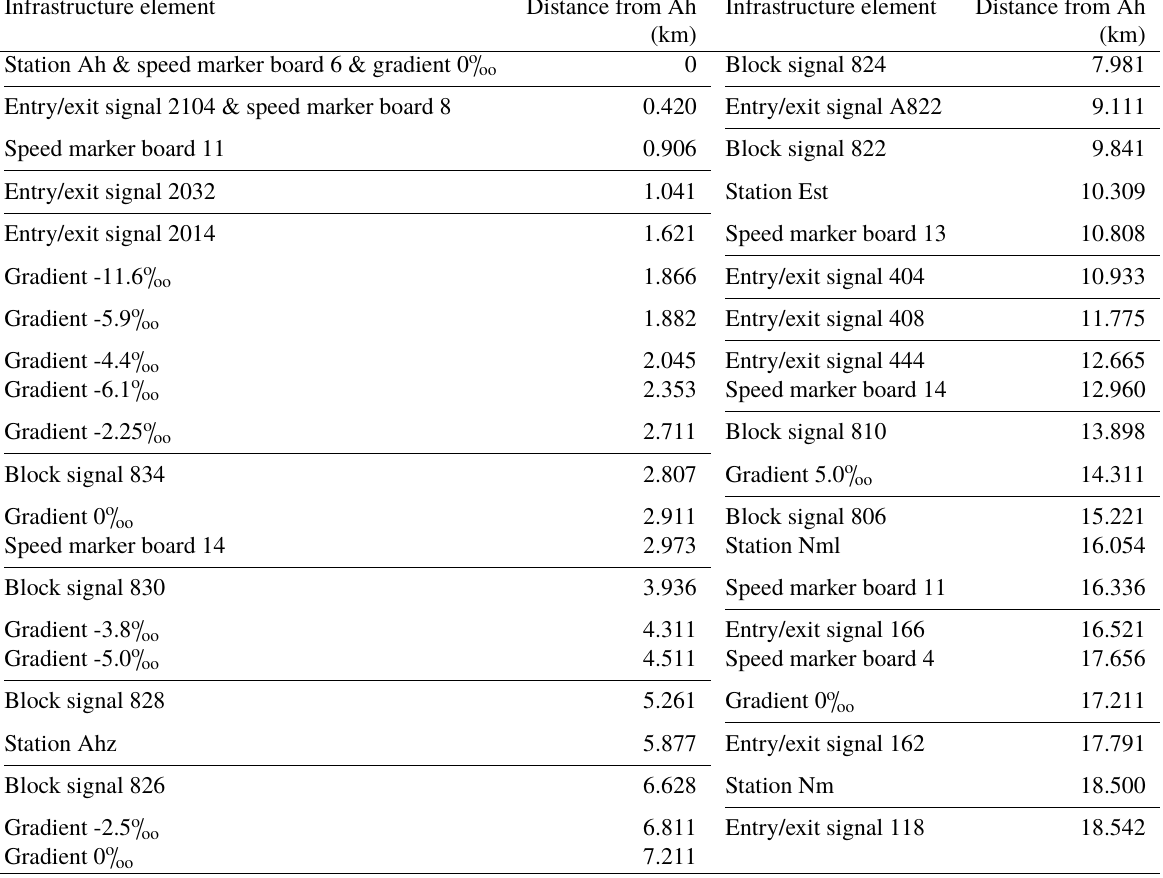
Table 6: Infrastructure elements and related distance towards station Ah divided into block sec- tions (ProRail, 2020). Legend: speed marker board indicates speed limit by multiplying the value by 10 (km/h), i.e., speed marker board 11 means speed limit of 110